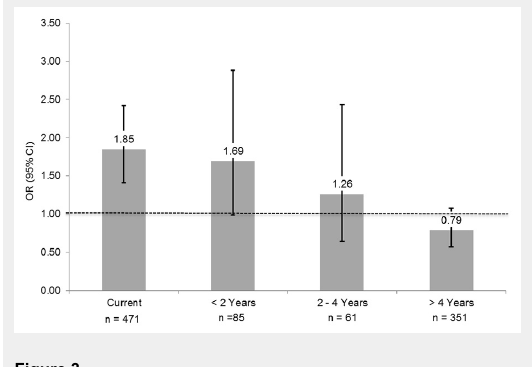
Relationship of pre-diabetes with time since smoking cessation. Never smokers represent the reference group. Boxes indicate odds ratios, whiskers are 95% confidence intervals. Data are adjusted for age, sex, Body Mass Index, hypertension, alcohol consumption, education, low density lipoprotein and high density lipoprotein cholesterol, physical activity, fruit/vegetable consumption and body composition.